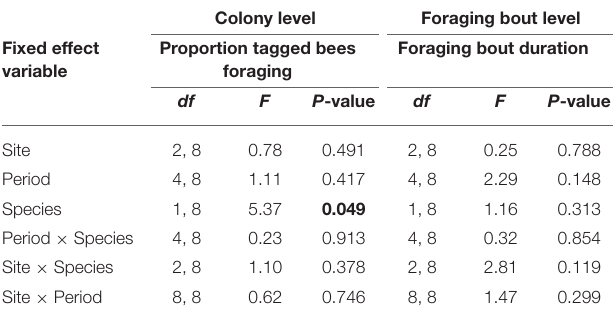
TABLE 4 | The impact of site, time period, bee species, and their two-way interactions on different metrics of bee foraging effort at the colony and foraging bout